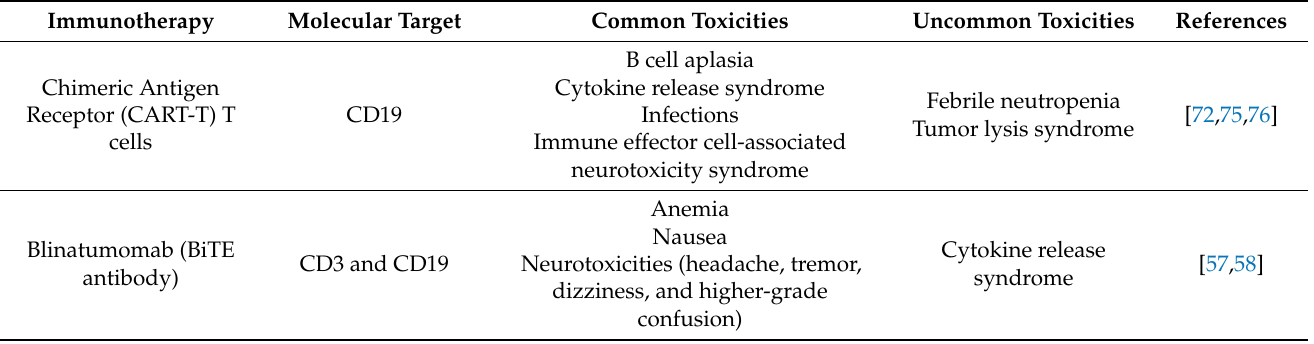
Table 2. Toxicity profile of CART-T and blinatumomab